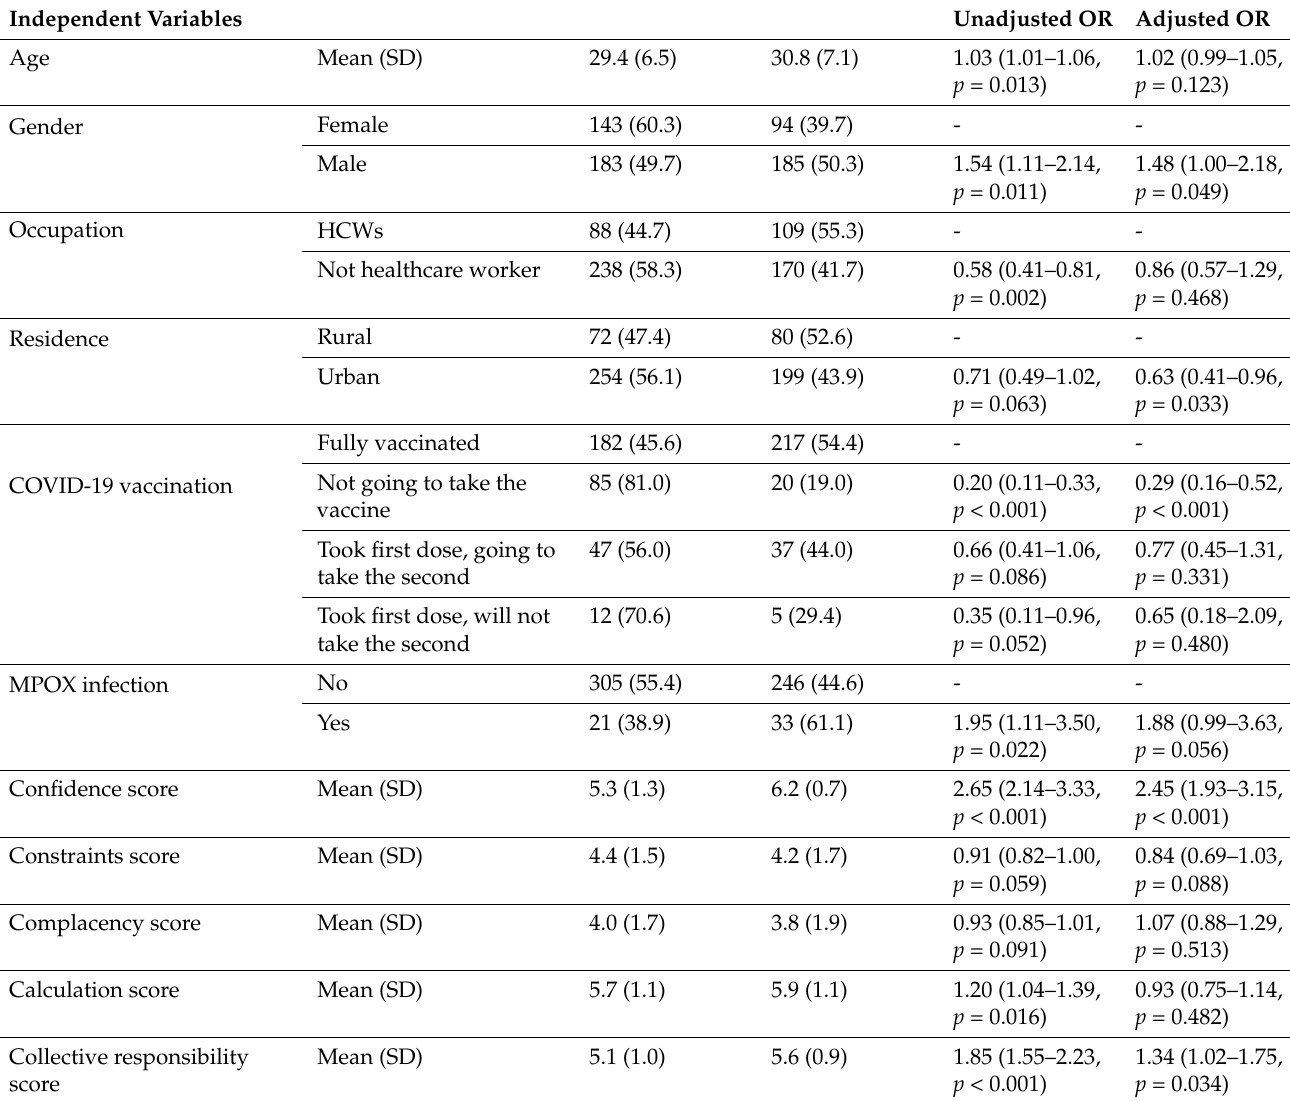
Table 3. Multivariate analysis of the determinant of MPOX vaccine